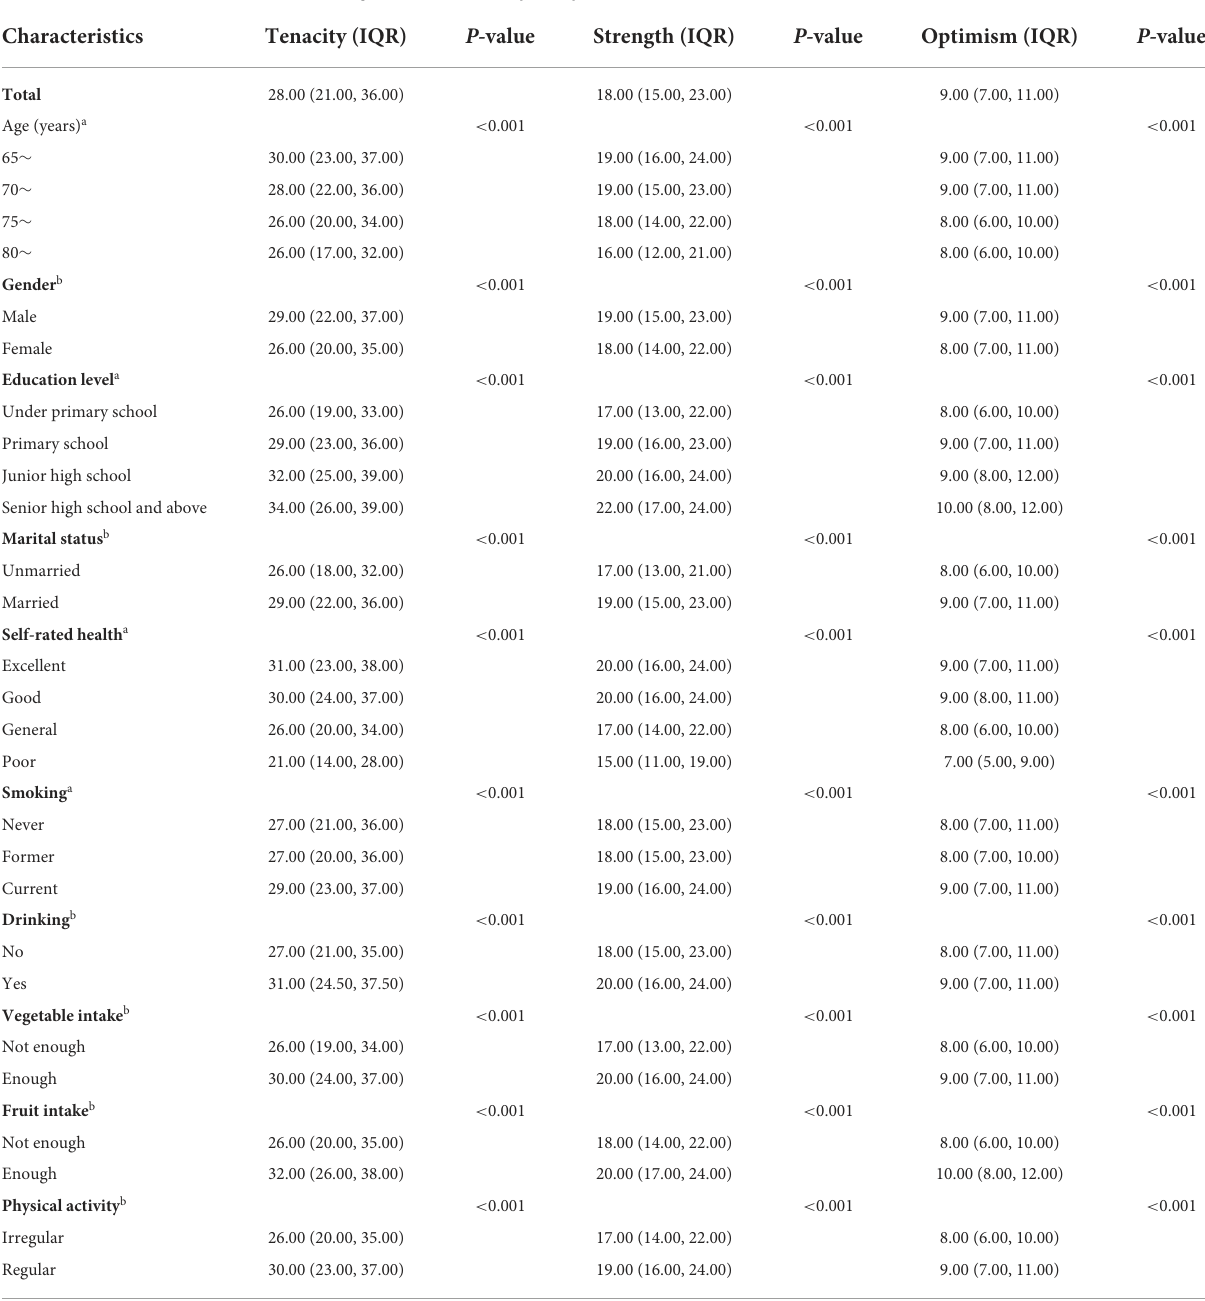
TABLE 2 Median of resilience scores (IQR) by characteristics of